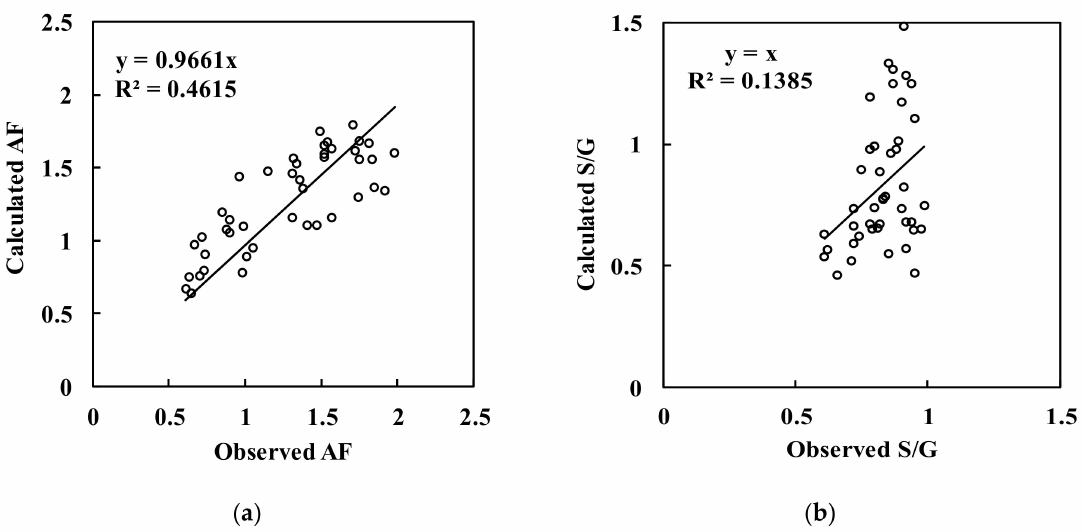
Figure 6. Scatter plots of calculated vs. observed AF ( a ) and S/G ( b